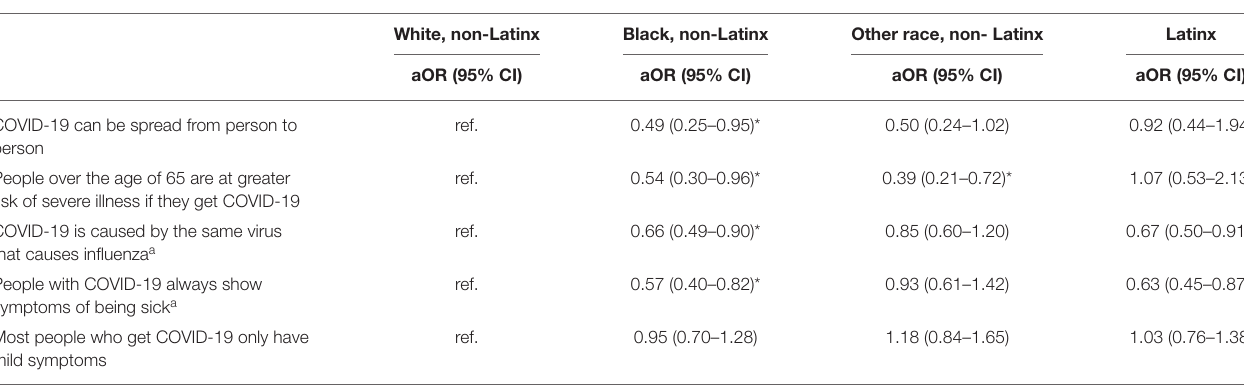
TABLE 2 | Knowledge about COVID-19 across racial/ethnic groups. White, non-Latinx Black, non-Latinx Other race, non- Latinx Latinx aOR (95% CI) aOR (95% CI) aOR (95%